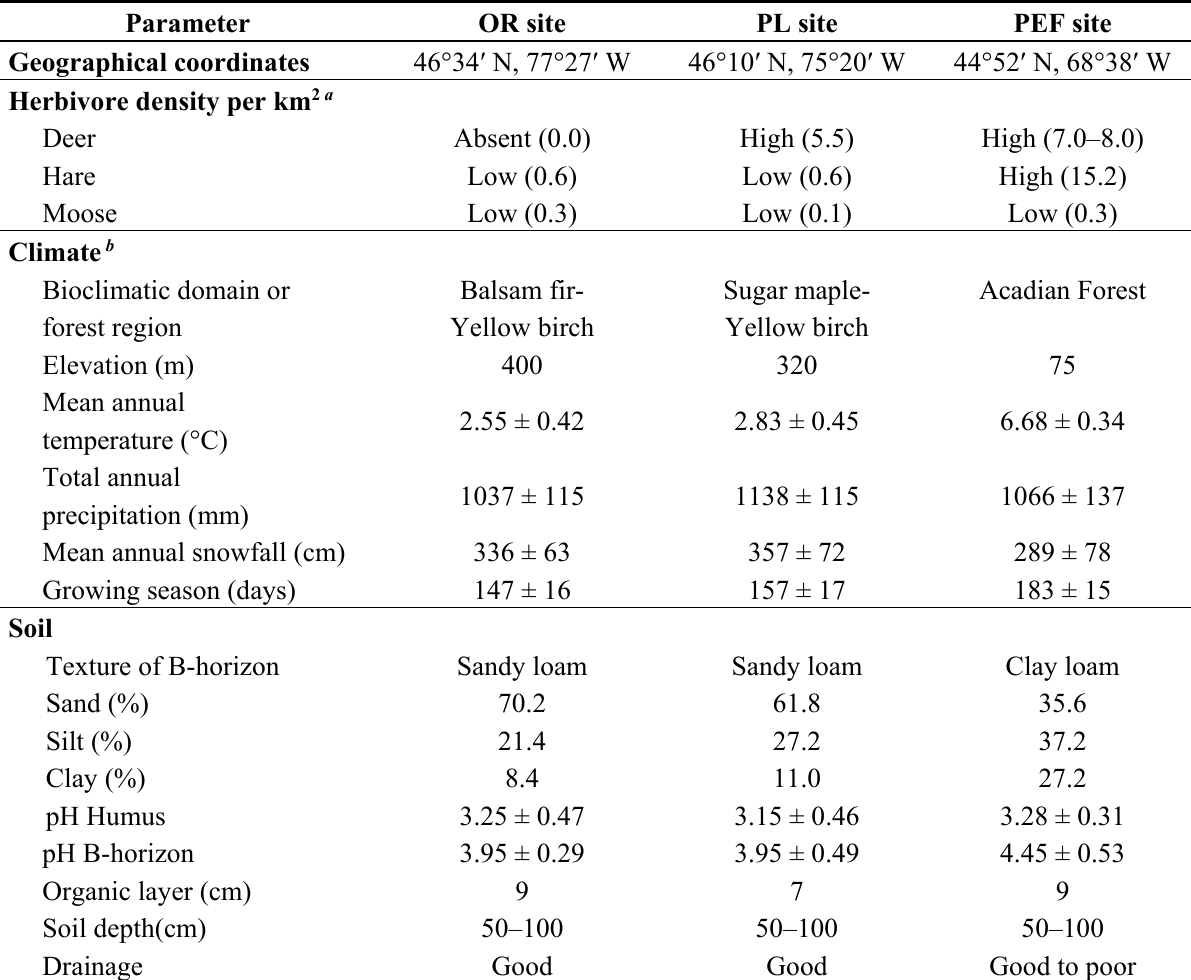
Table 1. Ecological characteristics of the 3 study sites: Outaouais Region (OR site), Papineau-Labelle wildlife reserve (PL site), and Penobscot Experimental Forest (PEF